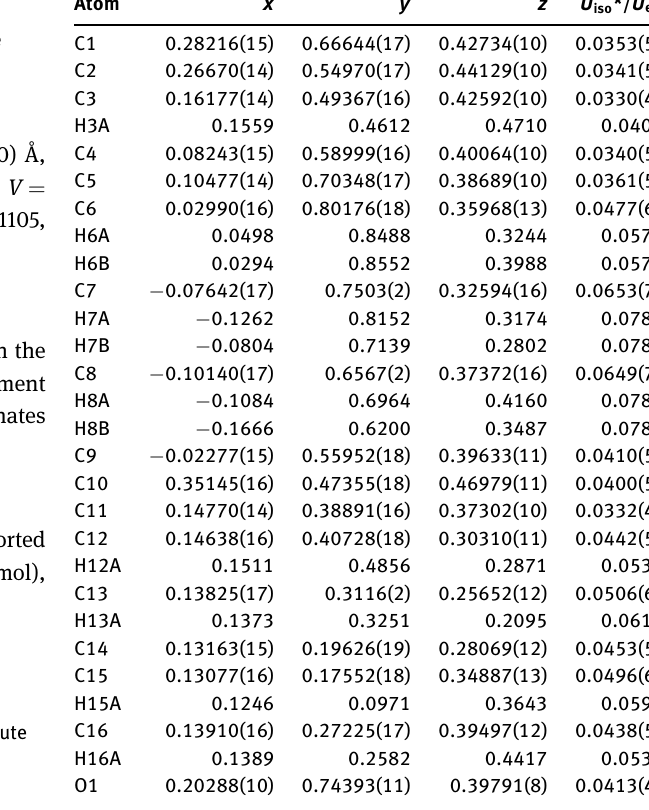
Table 2: Fractional atomic coordinates and isotropic or equivalent isotropic displacement parameters (Å 2